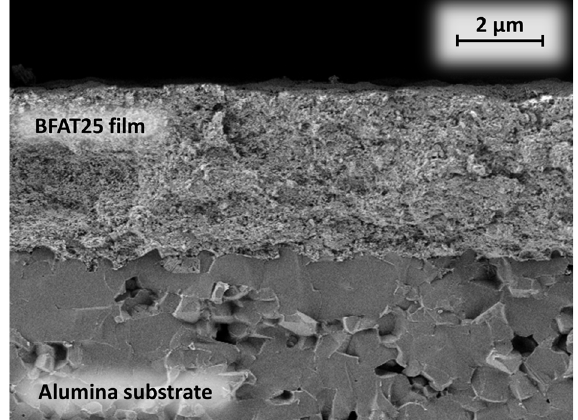
Figure 4. SEM micrograph of the nanocrystalline BFAT25 fi lms on the alumina